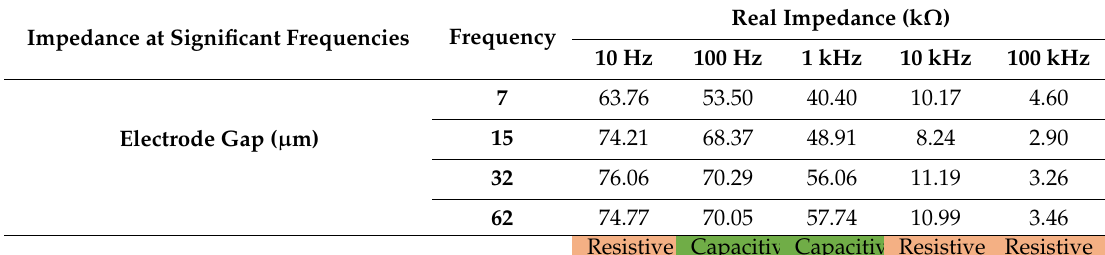
Table 2. Values of the real part of the impedance at significant